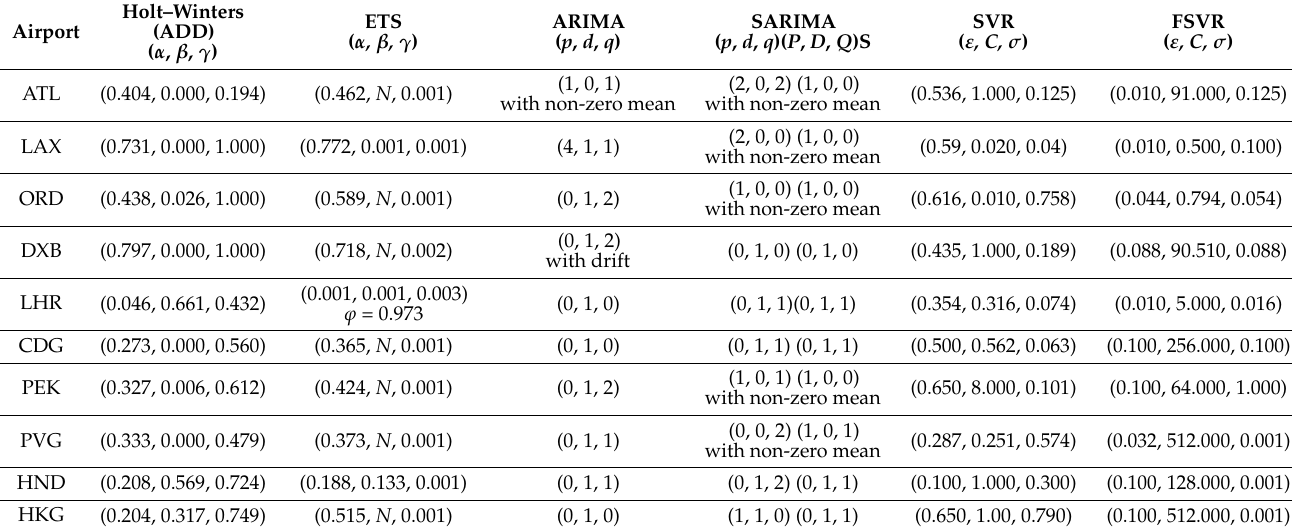
Table 3. Parameters related to each forecasting model of freight